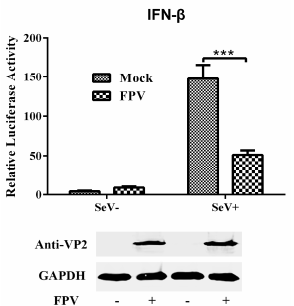
Figure 1. Effect of feline panleucopenia virus (FPV) on interferon (IFN)- β production and Sendai virus (SeV)-mediated IFN- β production as indicated by luciferase activity in F81 cells. The cells in this experiment were co-transfected with IFN- β -Luc and the Renilla luciferase construct pRL-TK, followed by a mock infection or infection with FPV. After 12 h of co-transfection, the cells were stimulated with SeV (SeV+) or left untreated (SeV-). The data represent the relative firefly luciferase activity normalized to the Renilla luciferase activity. The data represent the mean values of three independent experiments. The error bars represent standard deviations, and the asterisks indicate significant differences (*: p < 0.05; **: p < 0.01; ***: p < 0.001) between groups. The FPV infection was monitored by immunoblotting using a mouse anti-capsid protein 2 (VP2) antibody, and glyceraldehyde 3-phosphate dehydrogenase (GAPDH) was used as a loading